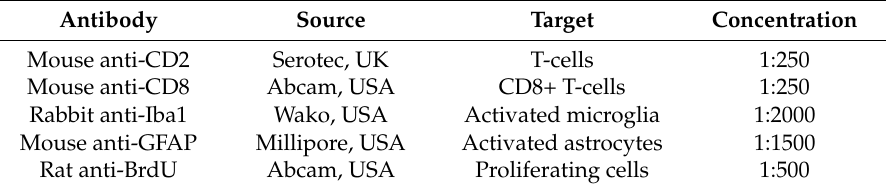
Table 1. Primary antibodies used for immunofluorescence.